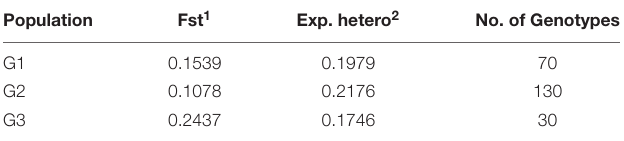
TABLE 2 | The results of STRUCTURE analysis of 230 lines in the Nebraska breeding program for the fixation index (Fst) (significant divergences), average distances (expected heterozygosity) and number of genotypes in each